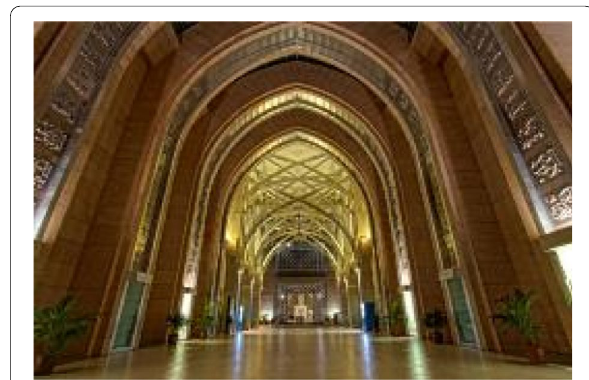
Fig. 12 Calligraphy along the corridors’ highlighted sides (GKD, 2019)